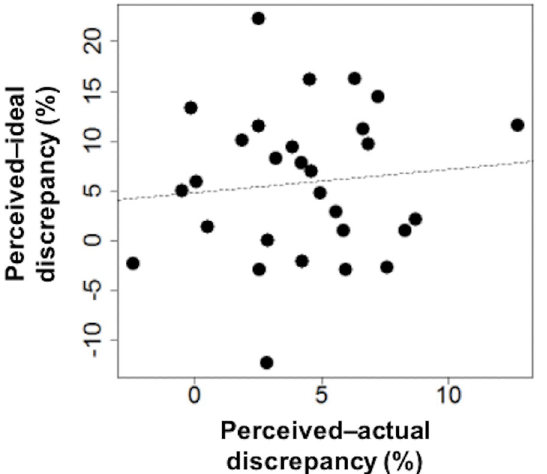
Fig 3. Scatterplot of the perceived–actual discrepancy and perceived–ideal discrepancy. The correlation between perceived–actual discrepancy and perceived–ideal discrepancy was not significant (df = 27, r = 0.10, p = 0.60).